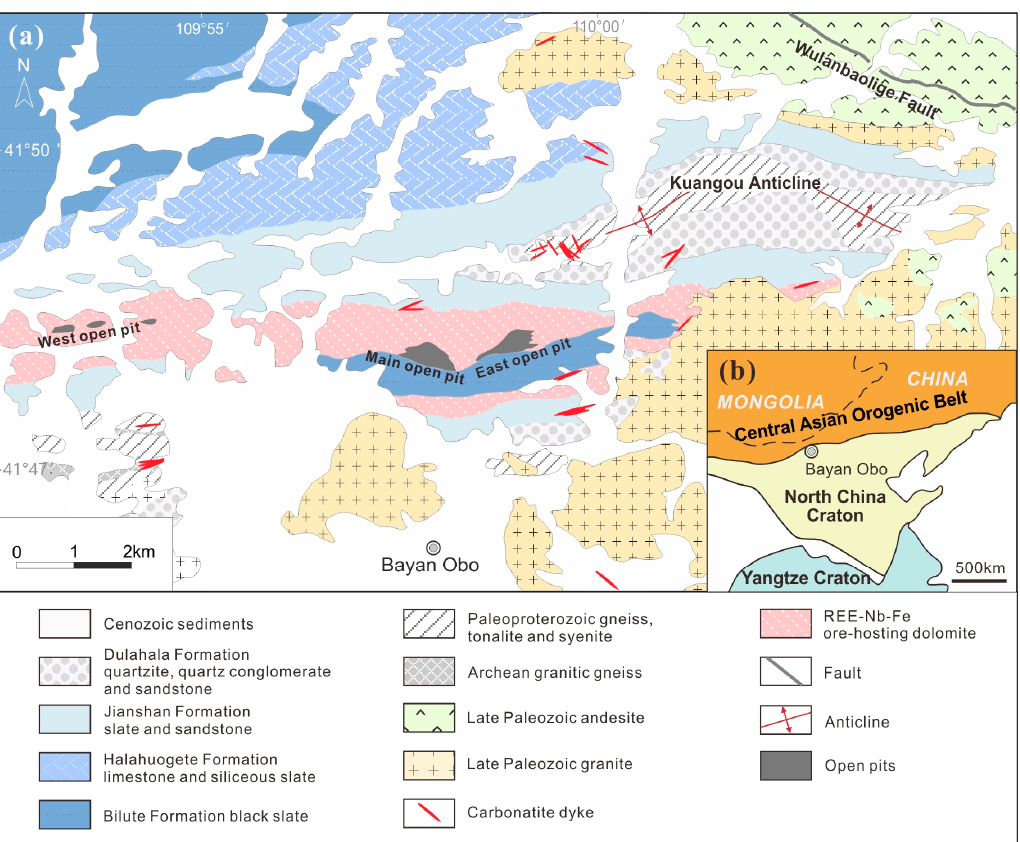
Figure 1. The geological setting of the Bayan Obo REE-Nb-Fe deposit (adapted from Yang et al. [18]) has been plotted in ( a ). The location of the Bayan Obo deposit in China is marked in the interior plot ( b ).